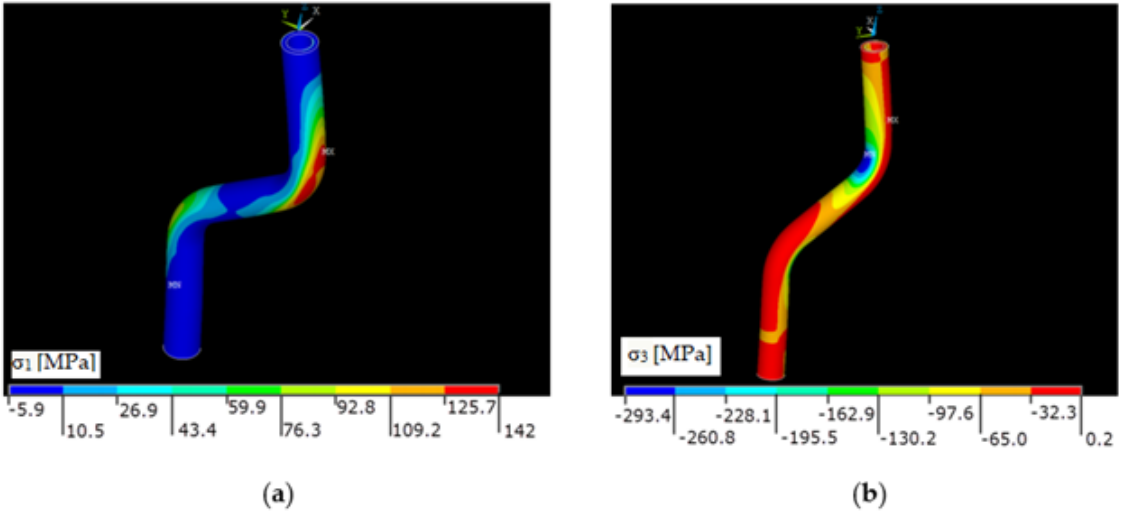
Figure 8. ( a ) Distribution of the first principal stress σ 1 on the composite part in (MPa), ( b ) DistribuTable 3. on the composite part in (MPa).